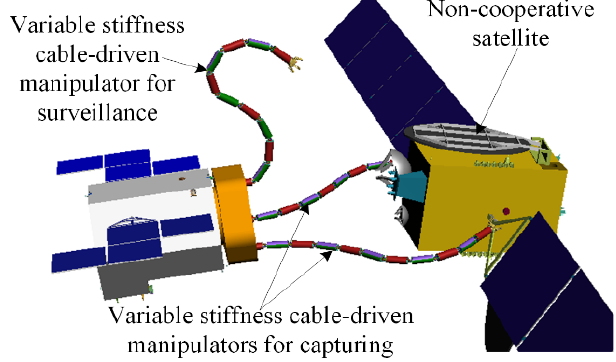
Figure 1. Concept of capturing a non-cooperative satellite.